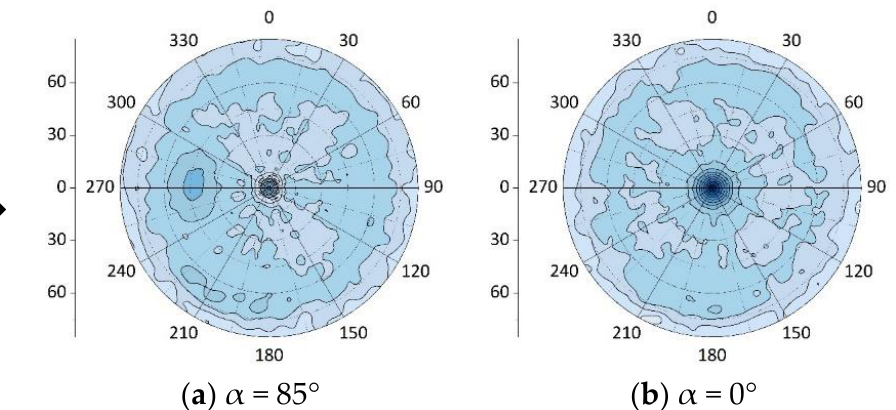
Figure 7. AlN 0002 pole figures for samples grown for 30 min at 1.5 mTorr using ( a ) GLAD and ( b ) normal deposition configuration with black arrows indicating the direction of incoming flux. Figure 8 summarizes the above results.